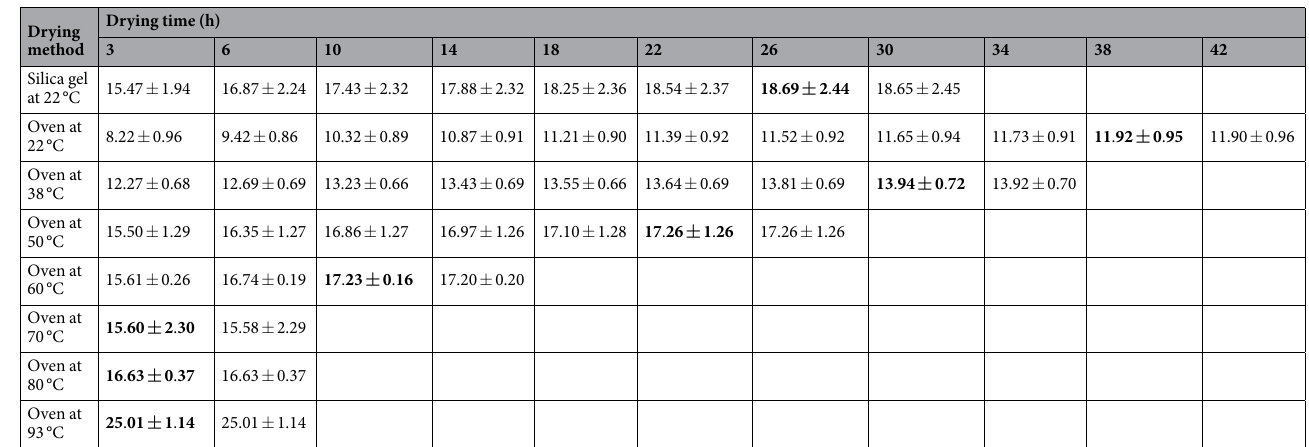
Table 3. The percentage of weight reduction due to water loss during drying of Trametes versicolor fruiting bodies by different drying methods and at different drying times * (mean ± SD, n = 3). * The bold values in the table are the final, constant water loss ratio for each drying